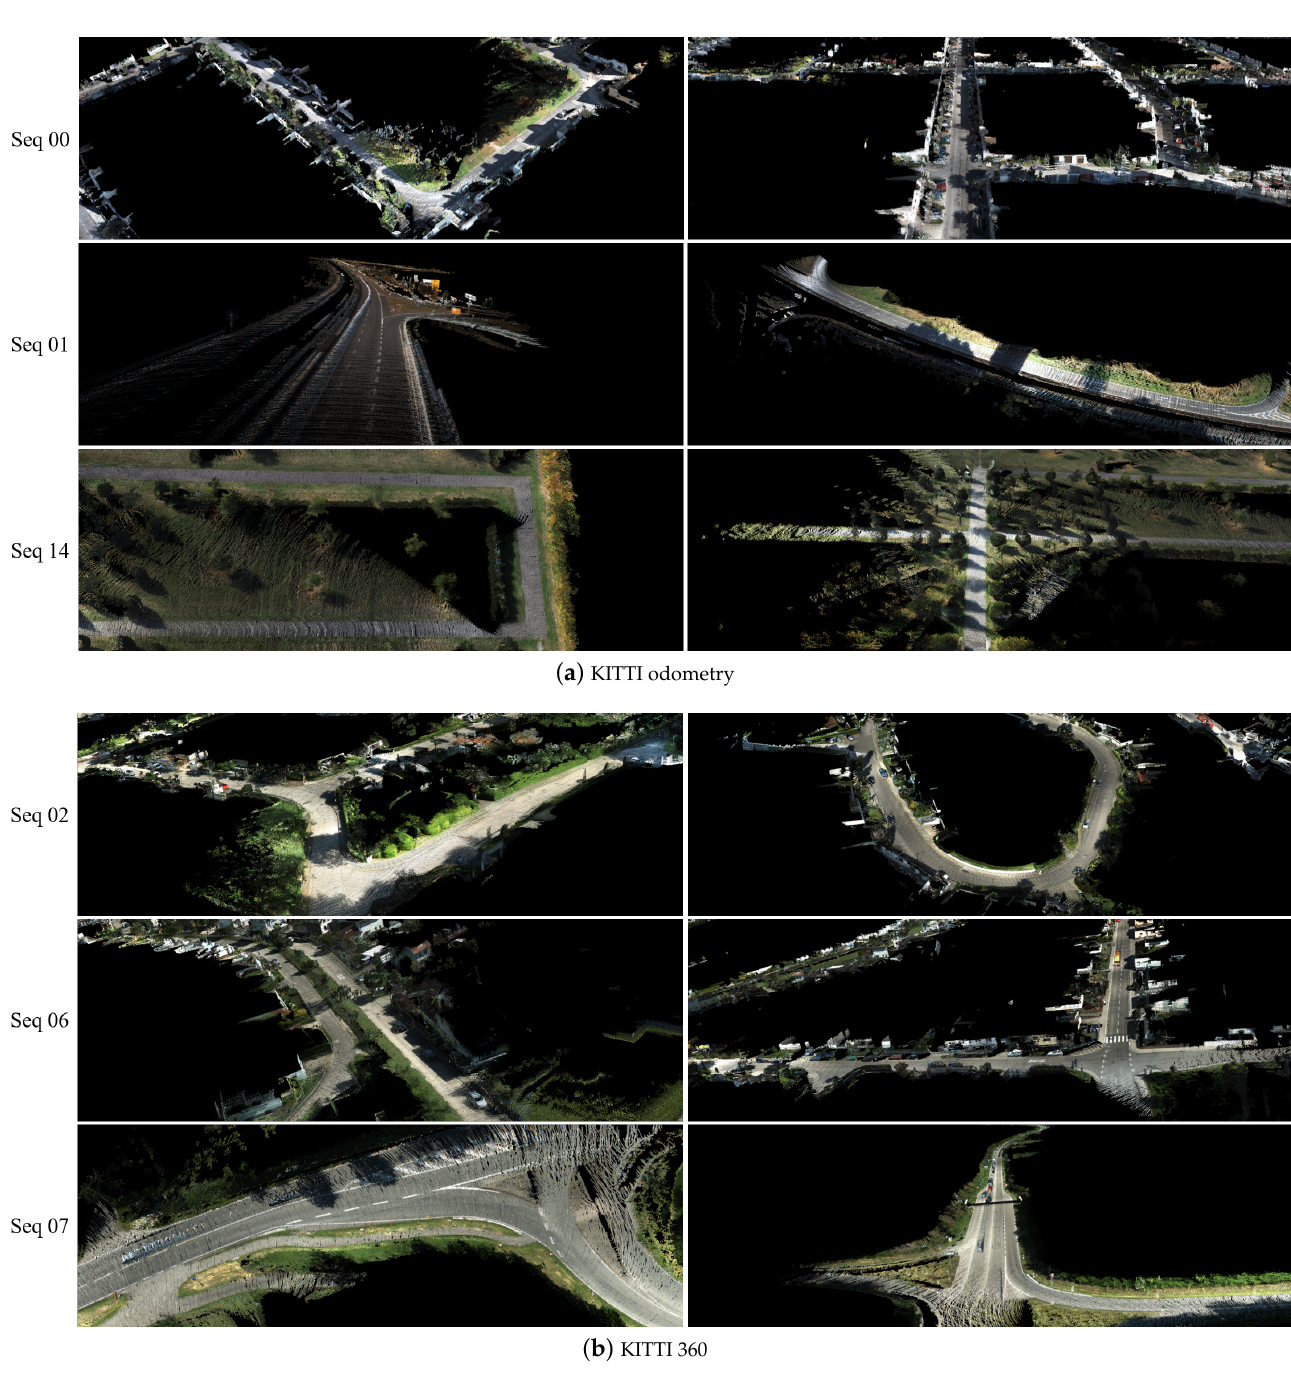
Figure 8. Examples of the reconstructed 3D colorized maps created by fusing the data of LiDAR and camera from the KITTI odometry and KITTI 360 datasets. The extrinsic parameters were provided by CFNet, with the initial parameters from